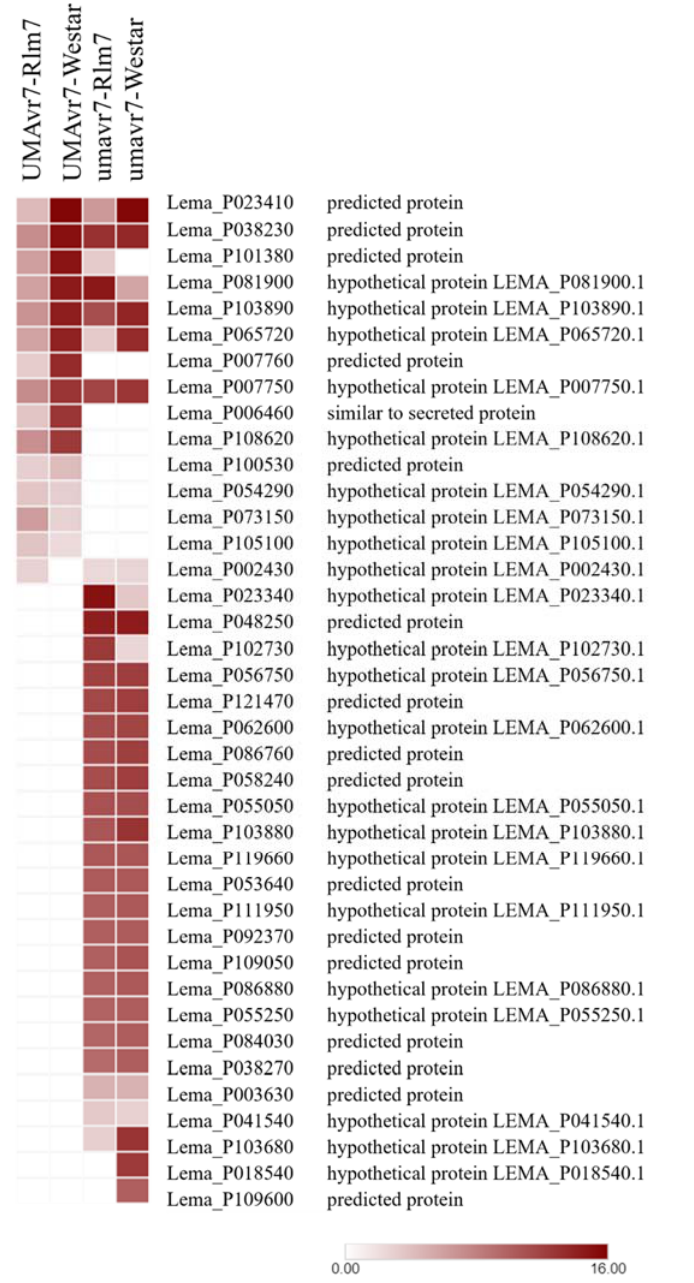
Figure 7. Differentially expressed effector genes of Leptosphaeria maculans isolates, UMAvr7 and umavr7 in Brassica napus genotypes, Rlm7 and Westar. The heatmap shows the differentially expressed effector genes of UMAvr7 and umavr7 in planta compared to 0-dpi. The results were considered at the fold-change cutoff (logFC) of ≥ 1 and ≤− 1 and false discovery rate (FDR) of ≤ 0.05. Locus and putative annotation of L. maculans effector genes, and log fold-change expression of each gene under each interaction are shown. UMAvr7: wild type isolate with AvrLm7 ; umavr7: mutant of AvrLm7 ; Rlm7: Brassica napus genotype 01-23-2-1 with Rlm7 ; Westar: susceptible check with no R genes. Results were representative of three biological replicates.